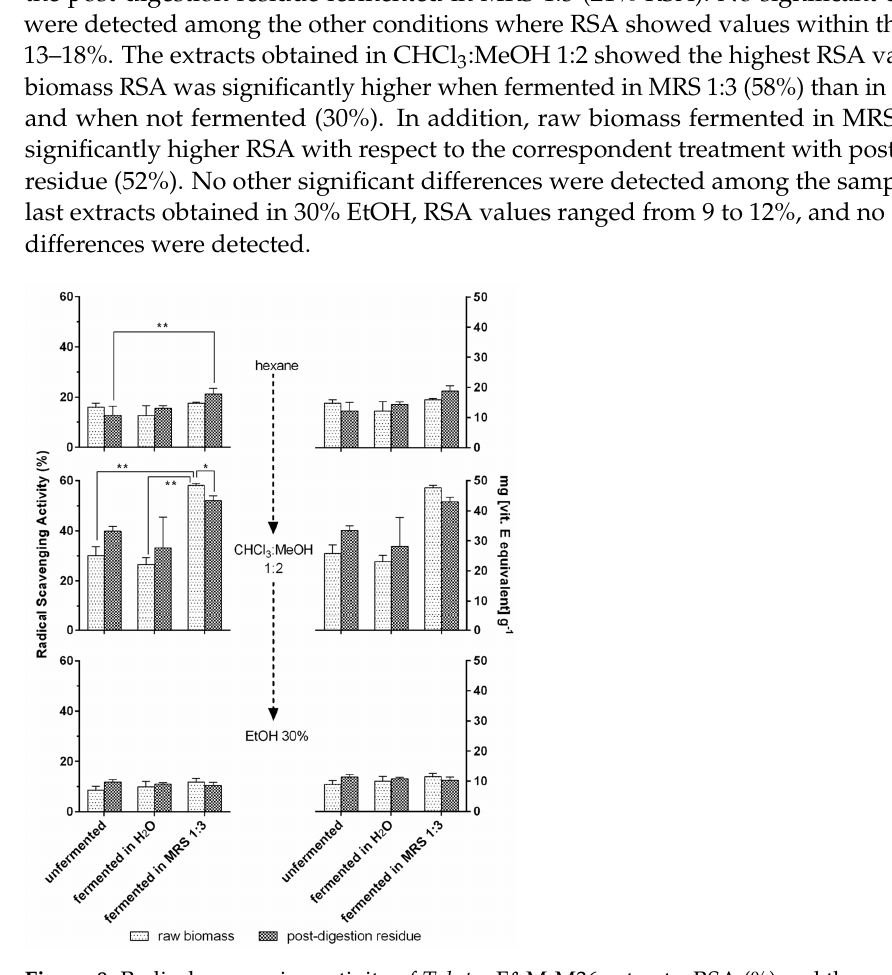
Figure 8. Radical scavenging activity of T. lutea F&M-M36 extracts. RSA (%) and the corresponding vitamin E equivalents (mg [Vit. E equivalent] g − 1 ) of T. lutea F&M-M36 raw biomass and postdigestion residue, unfermented or fermented in H ₂ O or MRS 1:3, sequentially extracted in hexane, CHCl 3 : MeOH 1:2 and 30% EtOH. Data are expressed as mean ± standard error. ** significant differences ( p < 0.01); * significant differences ( p < 0.05).